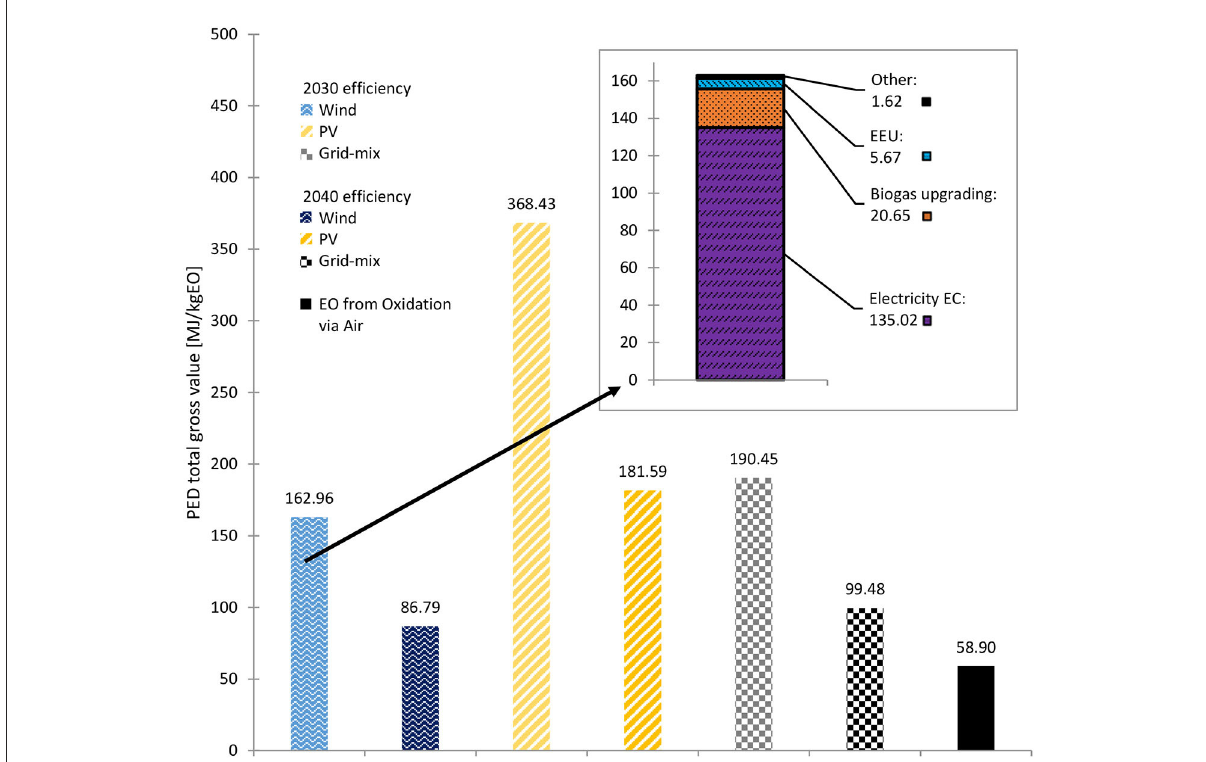
FIGURE8 PED of the 2030 and 2040 biogenic CO 2 scenarios with different energy supplies and of conventionally produced EO. Stacked diagram: PED share of each process, for 2030 efficiencies, wind power and biogenic CO 2 . Source: own data and illustration except for data of EO from Oxidation via Air, which are taken from (GaBi sphera,